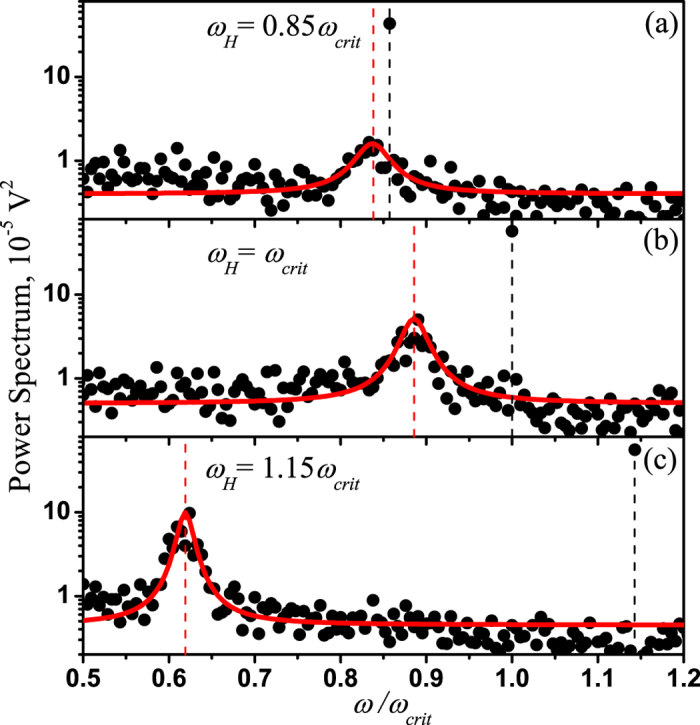
Experimental power spectra of the QPD voltage signals measured with the magnetic field rotating at a frequency near the critical point.The rotational frequencies of the magnetic field were ωH = 0.85ωcrit (panel (a)), ωH = ωcrit (panel (b)), and ωH = 1.15ωcrit (panel (c)). The red curves represent fits performed using the Lorenz function. The critical frequency was ωcrit = 131.9 rad/s.